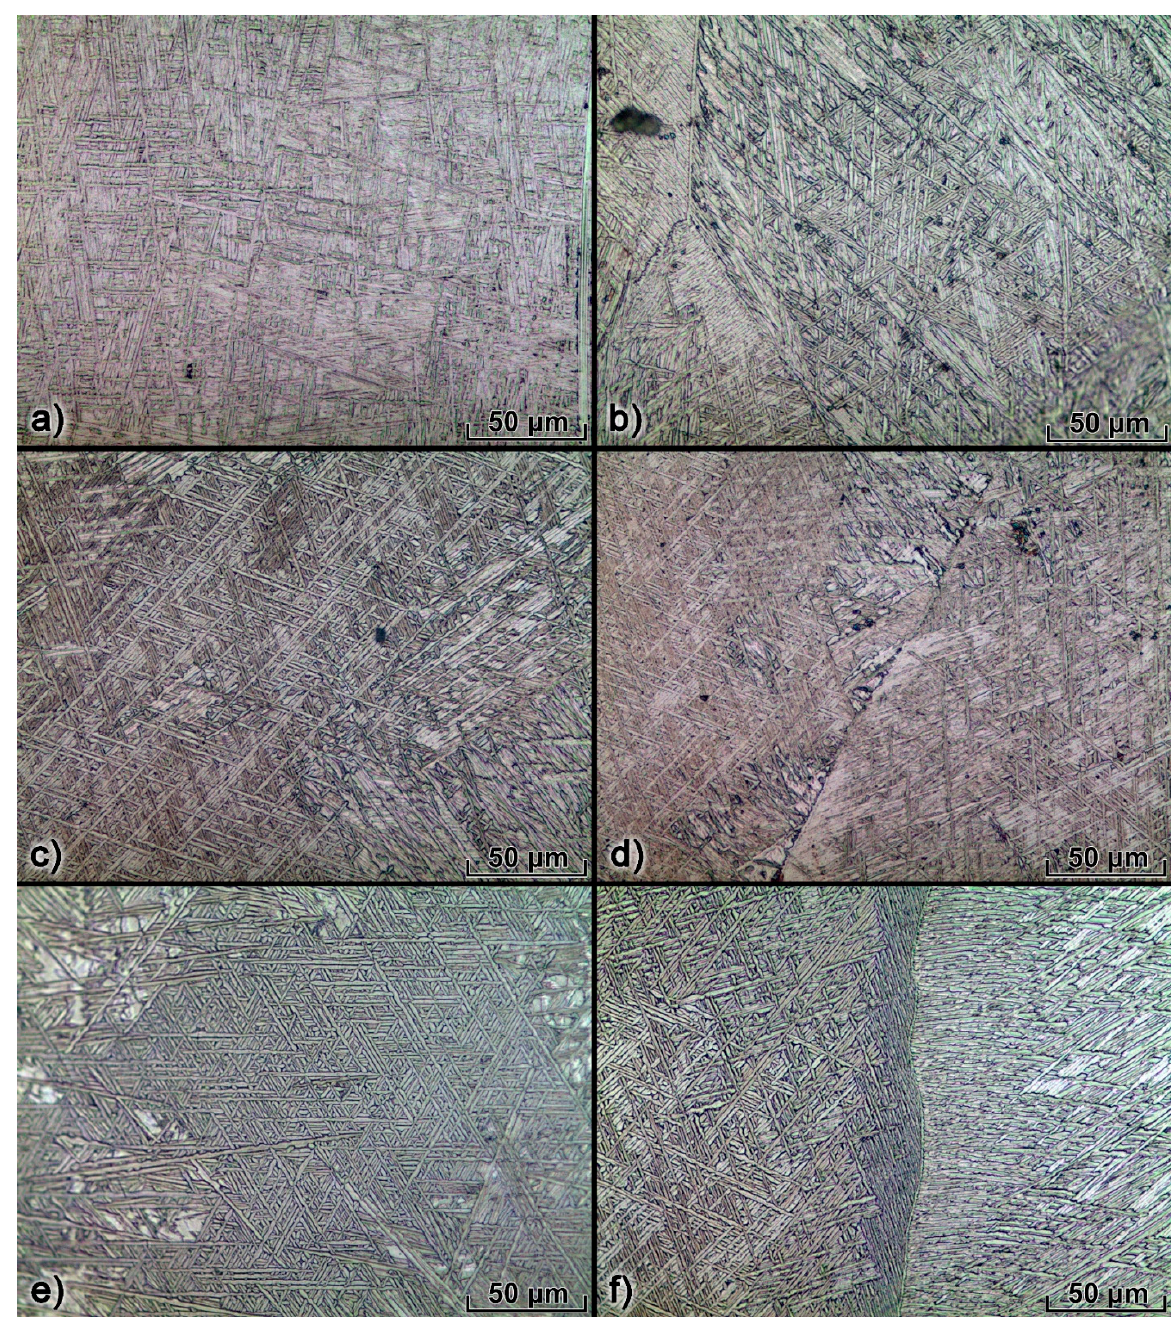
Figure 13. Each wall microstructure: ( a ) CMT α -basketweave in primary- β , ( b ) CMT α -colony along grain boundary, ( c ) CSC α -basketweave in primary- β , ( d ) CSC α -colony along grain boundary, ( e ) DCEN α -basketweave in primary- β , ( f ) DCEN α -colony along grain boundary.